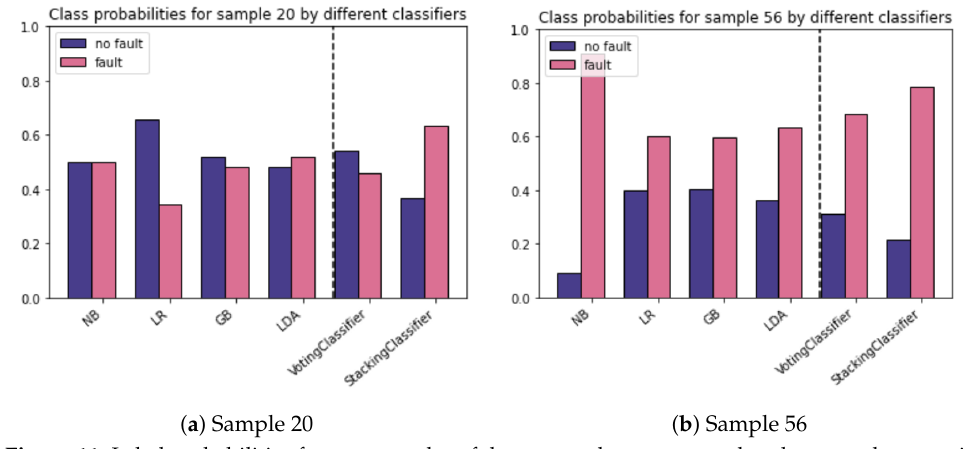
Figure 11. Label probabilities for two samples of the test set that correspond to the same dataset with the results shown in Table